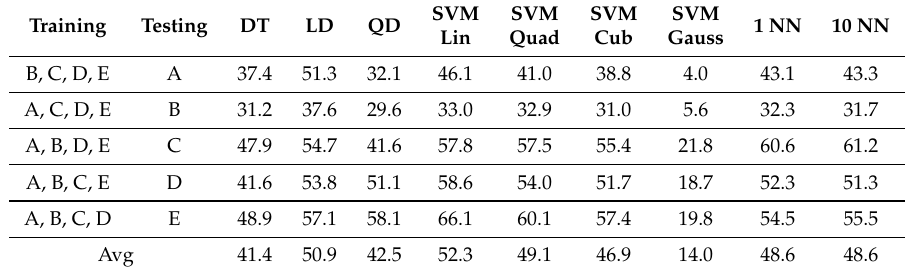
Table A1. Leave-one-subject-out cross-validation results for dataset 1, configuration (i), variant